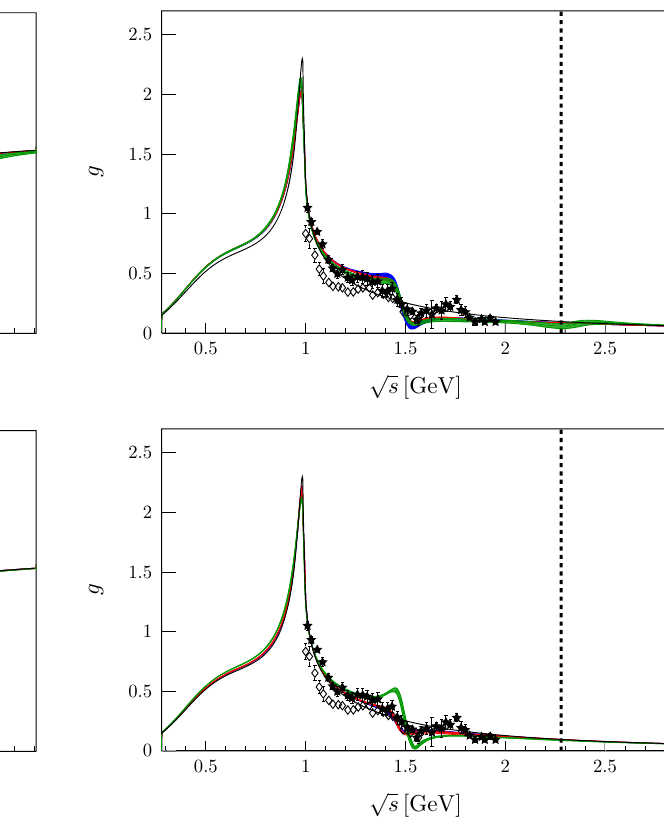
Fig. 10 Scalar isoscalar ππ → K ¯ K scattering phase shift ψ (left) and is shown in blue, Fit 2 in red, Fit 3 in green, and the input g 0 and ψ 0 absolute value g (right) defined by the S -wave amplitude T 12 = g e i ψ [40] in black. For comparison we show the amplitude analyses of Refs. [47] (open diamonds) and [48] (filled stars) for the fits with an additional ρρ (top) and σσ (bottom) channel. Fit 1 with the residues as coupling constants. With this we can deduce a branching ratio B f ( 1500 ) → ππ = ( 58 ± 31 ) %, where 0